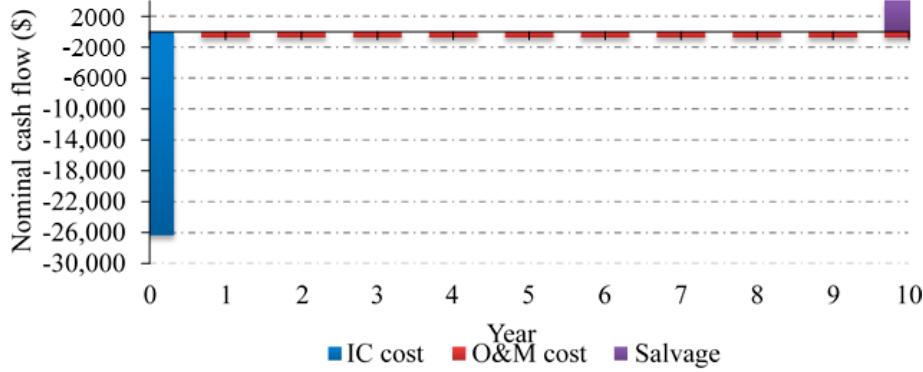
Figure 18. Cash flow summary within the project lifetime.